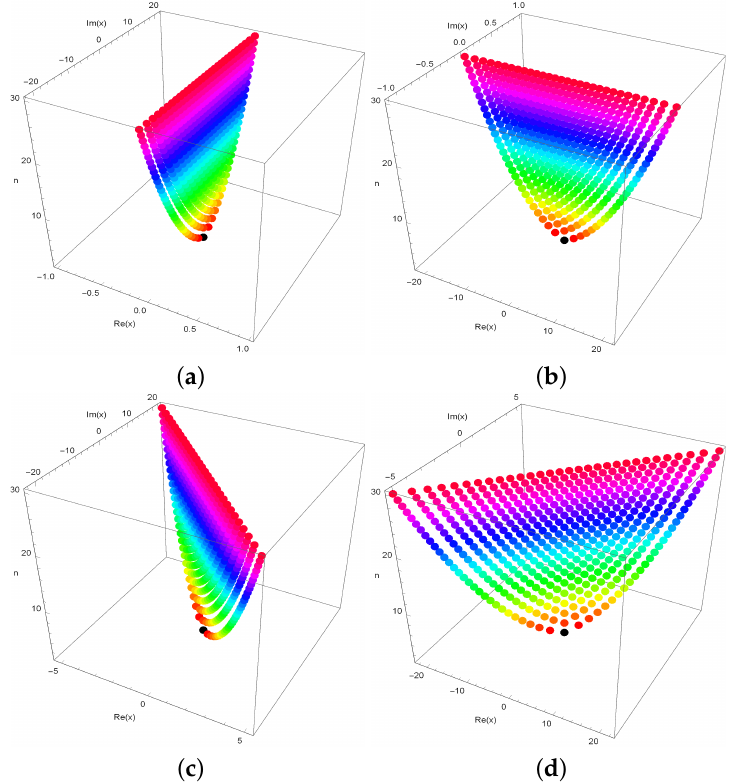
Figure 3. Stacks of zeros of H n ( x , y , λ ) = 0,1 ≤ n ≤ 30. ( a ) y = 2; ( b ) y = − 2 ; ( c ) y = 2 + i ; ( d ) y = − 2 − i .